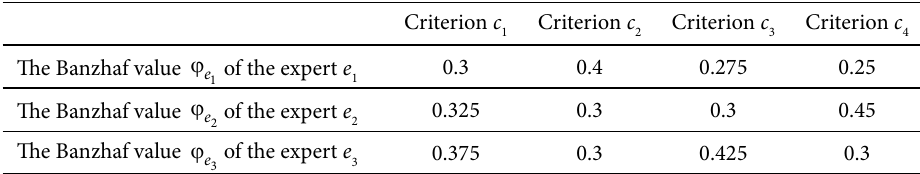
Table 1. The Banzhaf values of the experts w.r.t. each